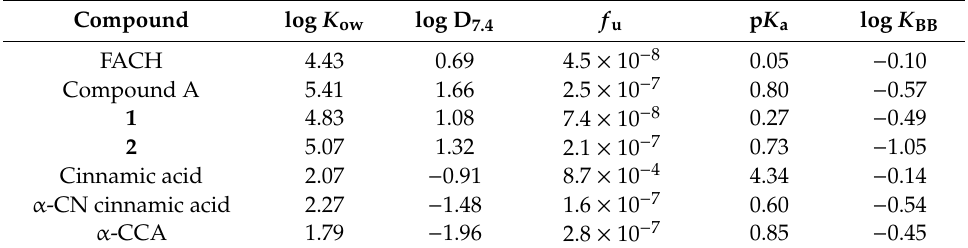
(Table 1), which holds correspondingly for the FACH log D 7.4 value (0.42 experimental [28] vs. 0.69 calculated) as well as for the respective di ff erence in log D 7.4